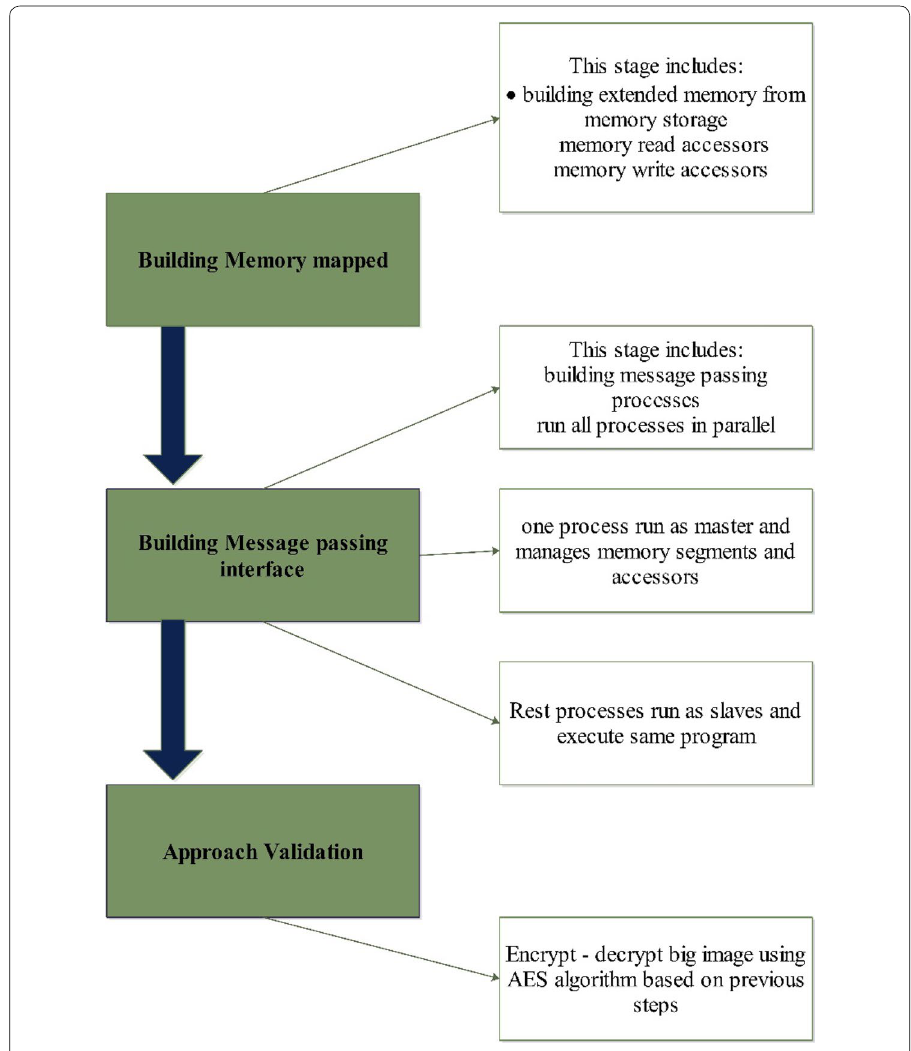
Fig. 1 The three stages of the proposed